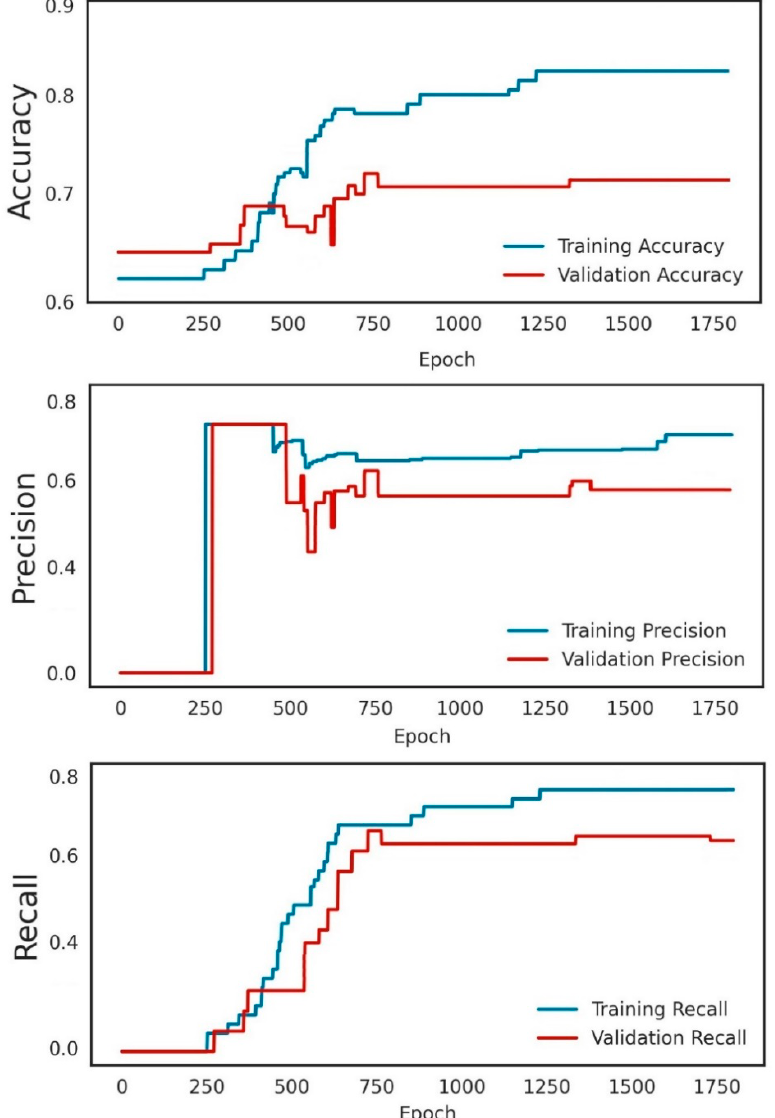
Figure 11. Training and validation diagrams for CNN model.